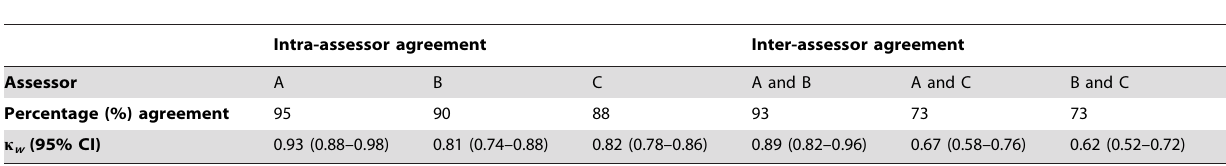
Table 3. Level of intra-and inter-assessor agreement for assessment of elephant body condition.